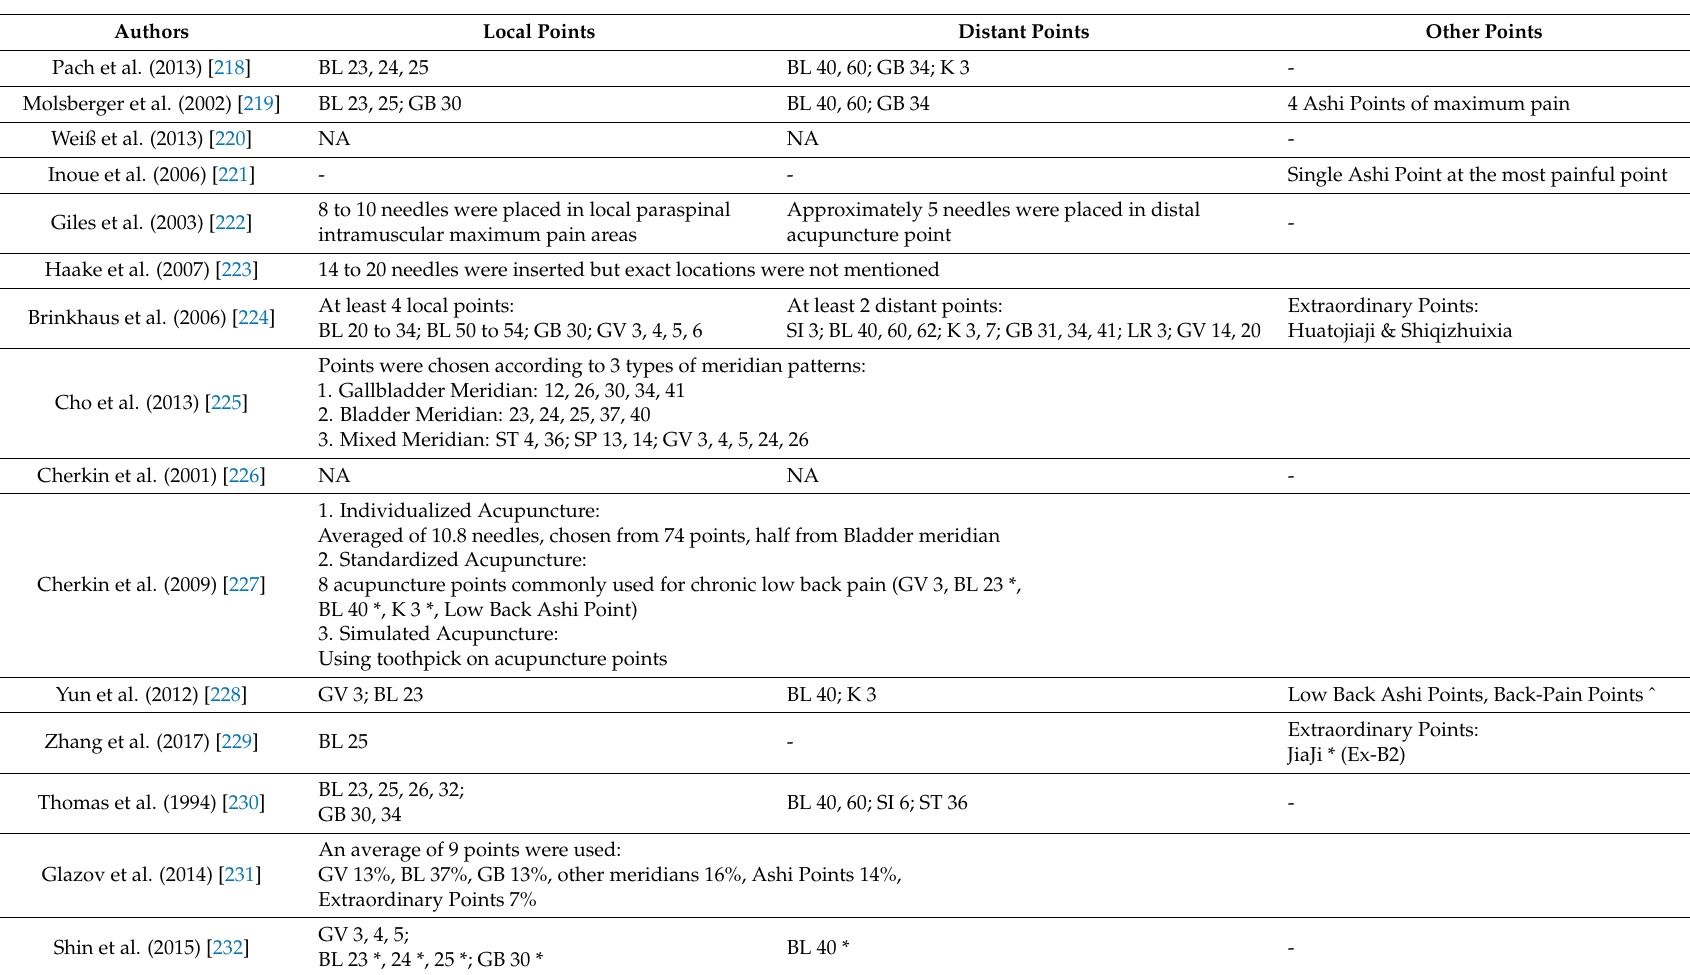
Table 2. Selection of acupuncture points of randomized control trials for treatment of lower back